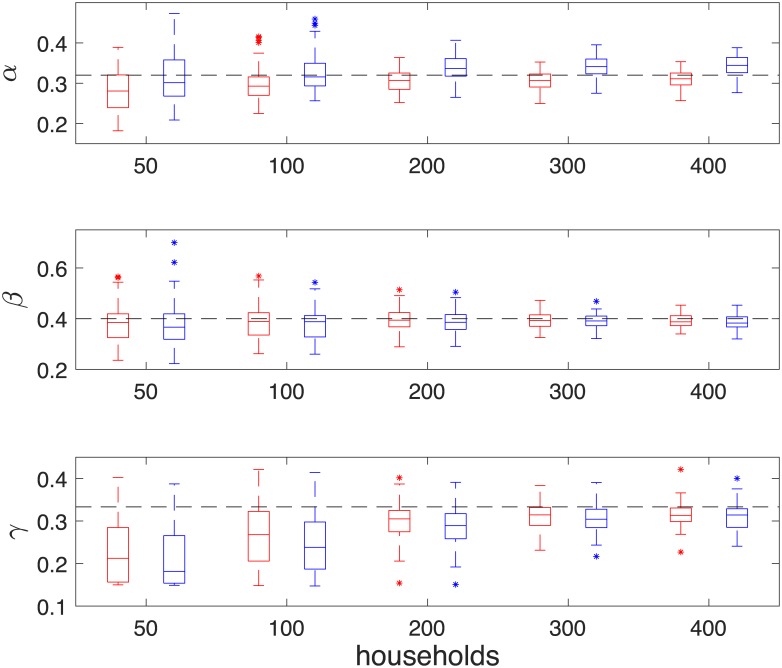
Boxplots of maximum a posteriori (MAP) estimates of (α, β, γ) from 50 simulations.Red and Blue boxes correspond to results from 2.5 × 106 iterations, thinned to 2.5 × 105 samples, of the DA-MCMC algorithm and 105 iterations of the BPA and respectively. MAP’s are calculated from 3 dimensional kernel density estimates. The pairs of boxes from left to right are MAP’s from inference based upon data with 50, 100, 200, 300 and 400 infected households. Black dotted lines indicate the true parameter values at (α, β, γ) = (0.32, 0.4, 1/3).